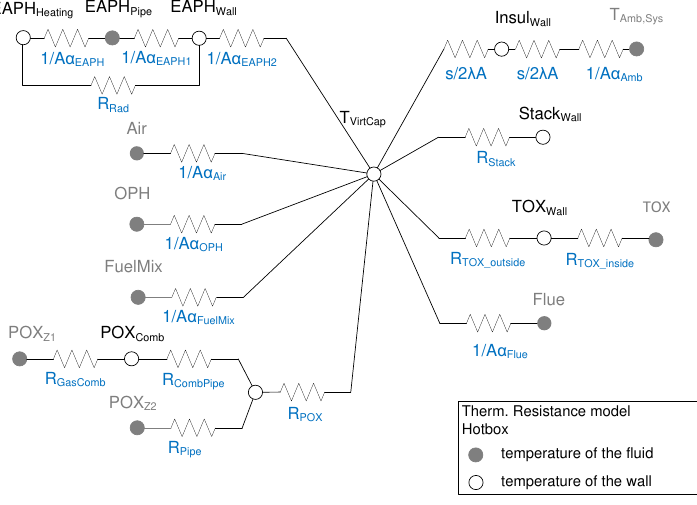
Figure 10. Thermal resistance model of the hotbox with visualization of the thermal resistance, nodal points and parameters to characterize the heat transfer, c.f.